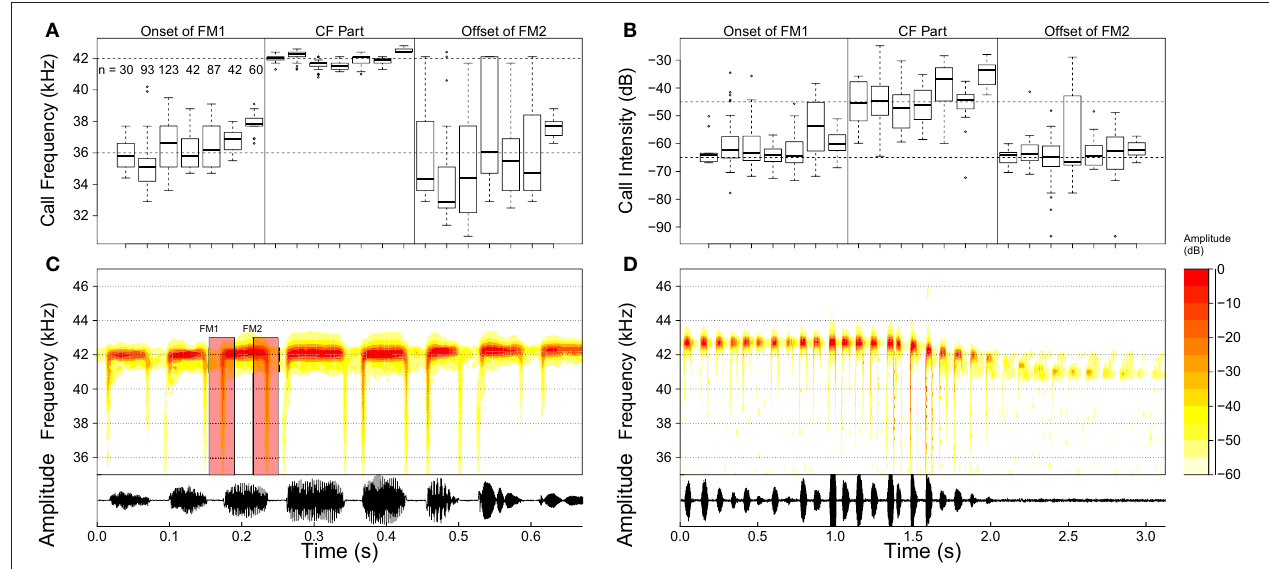
FIGURE 2 | (A) Boxplots for the frequency of the FM and CF parts for each of the seven bat specimens whose calls were analyzed. Open circles denote outliers defined as data points that lie below Q 1 − 1 . 5 × ( Q 3 − Q 1 ) or above Q 3 + 1 . 5 × ( Q 3 − Q 1 ) (with Q n the n th quartile). The number of calls analyzed for each individual are displayed in the leftmost section of